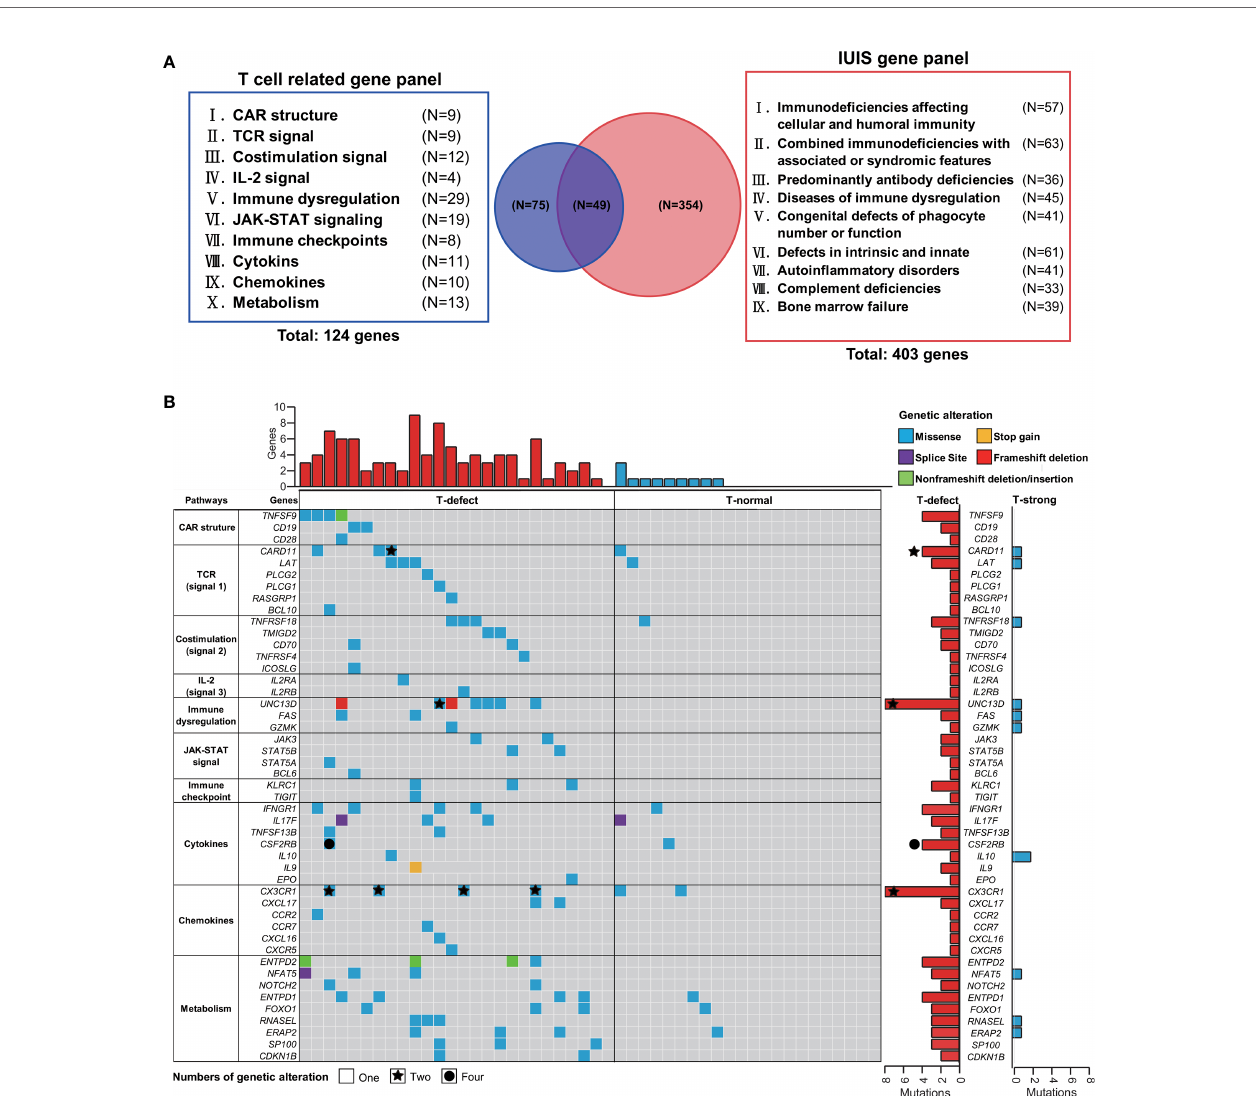
FIGURE 3 | Targeted gene panel of T-cell functions and waterfall plot of germline mutations. (A) One hundred and twenty-six target genes, including ten T-cell and CAR-T cell biology categories, were selected for the waterfall plot with T-cell grading information. Fifty genes were identical to primary genetic defects reported by the IUIS/WHO committee. (B) The top 47 mutated genes that differed between the two groups, such as TNFSF9 , CD19 , CARD11 , UNC13D , and CX3CR1 , were selected for the waterfall plot with T-cell group information. The genes were arranged according to the T cell-related gene panel in (A) . Each column corresponds to a sample, and cases are ordered by the lymphoma with T-defect on the left (red bar) and with T-normal (blue bar) on the right. The types of genetic alterations are shown as different colors as shown in the legend in the upper-right corner. The counts of genetic alterations are shown as none, stars, and circles, representing once, twice, and four times person-times, respectively. CAR, chimeric antigen receptor; JAK-STAT, Janus kinase-signal transducer and activator of transcription; IL-2, interleukin-2; IUIS, International Union of Immunological Societies; TCR, T-cell receptor; WHO, World Health